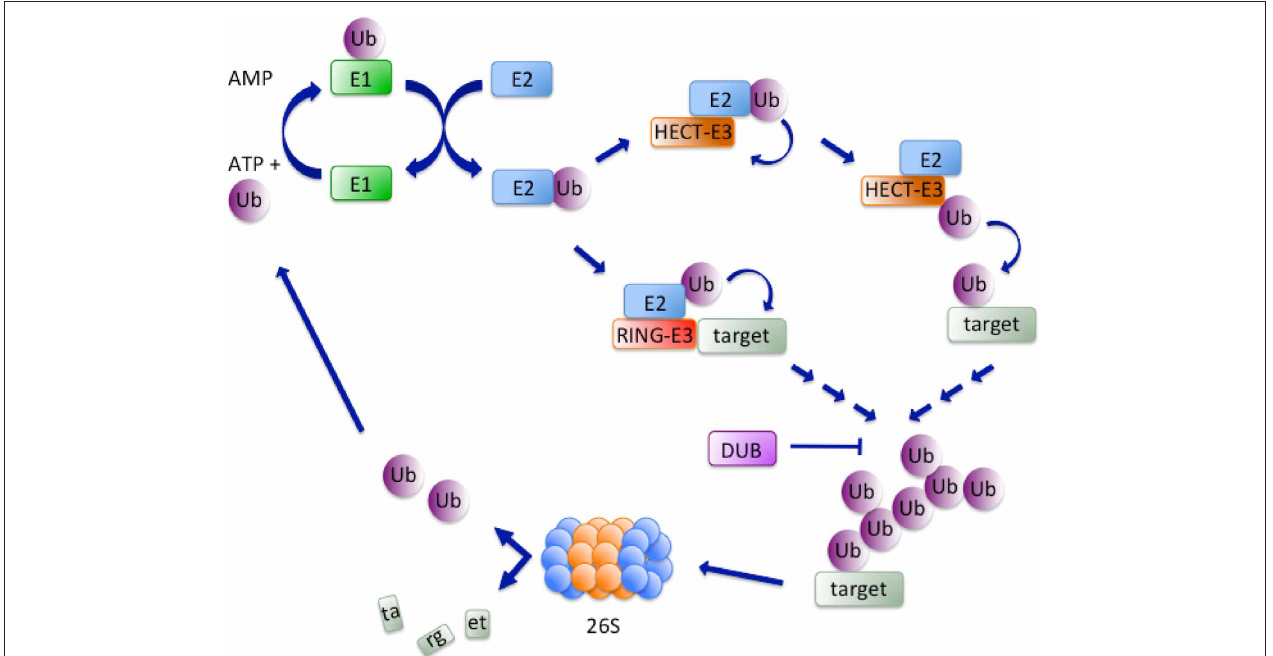
FIGURE 1 | Simplified scheme of ubiquitylation. The ubiquitylation cascade initiates with an ATP-dependent reaction consisting in the formation of a thiolester bond between a cysteine in the active site of the E1-activating enzyme and G 76 in Ubiquitin (Ub). Next, Ubiquitin is transferred to the active cysteine of an E2-conjugating enzyme that interacts with an E3-ligase. The latter can either directly transfer